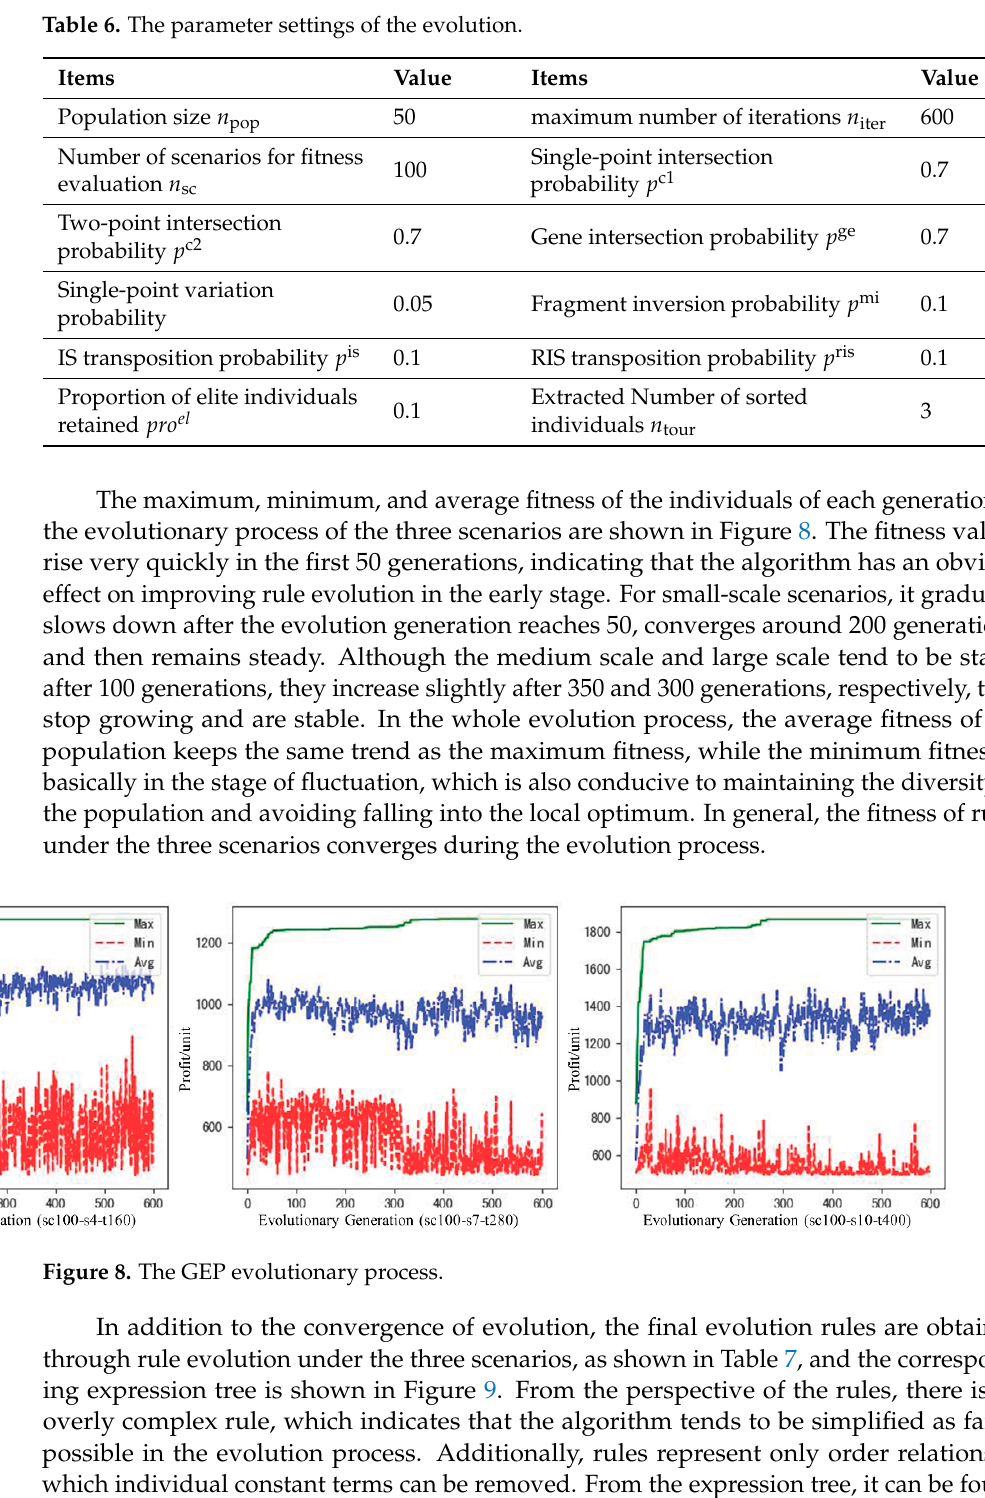
Table 7. The results of optimal evolution rules.